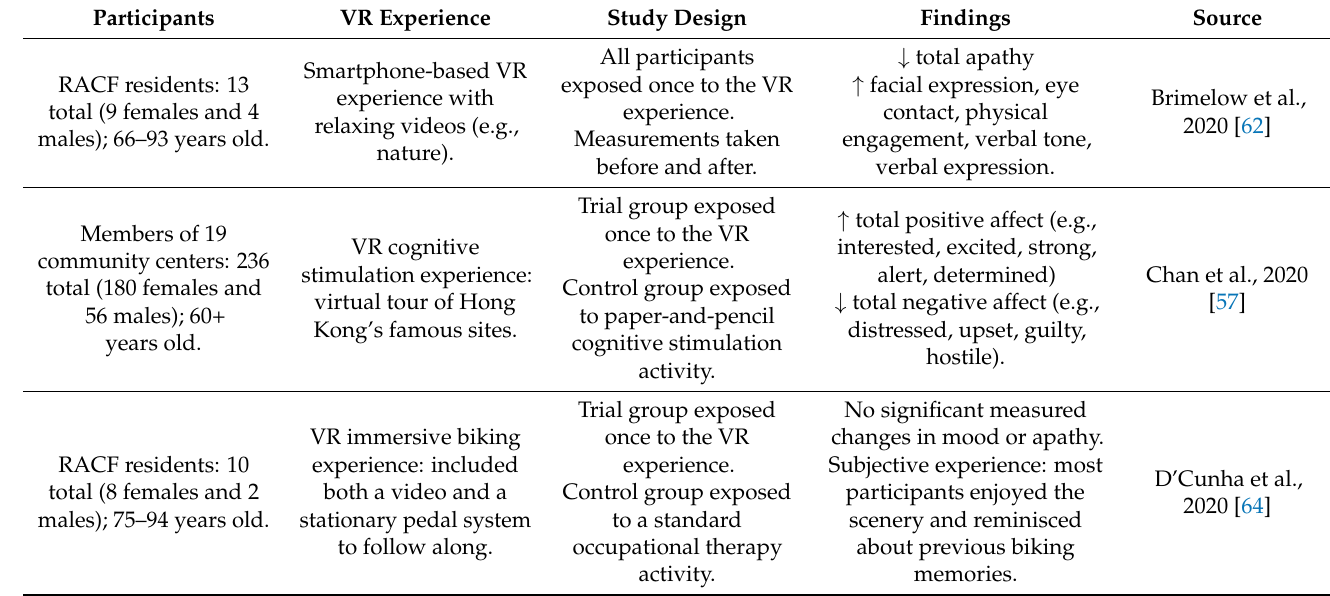
Table 1. Effects of VR on mood and cognitive function in older